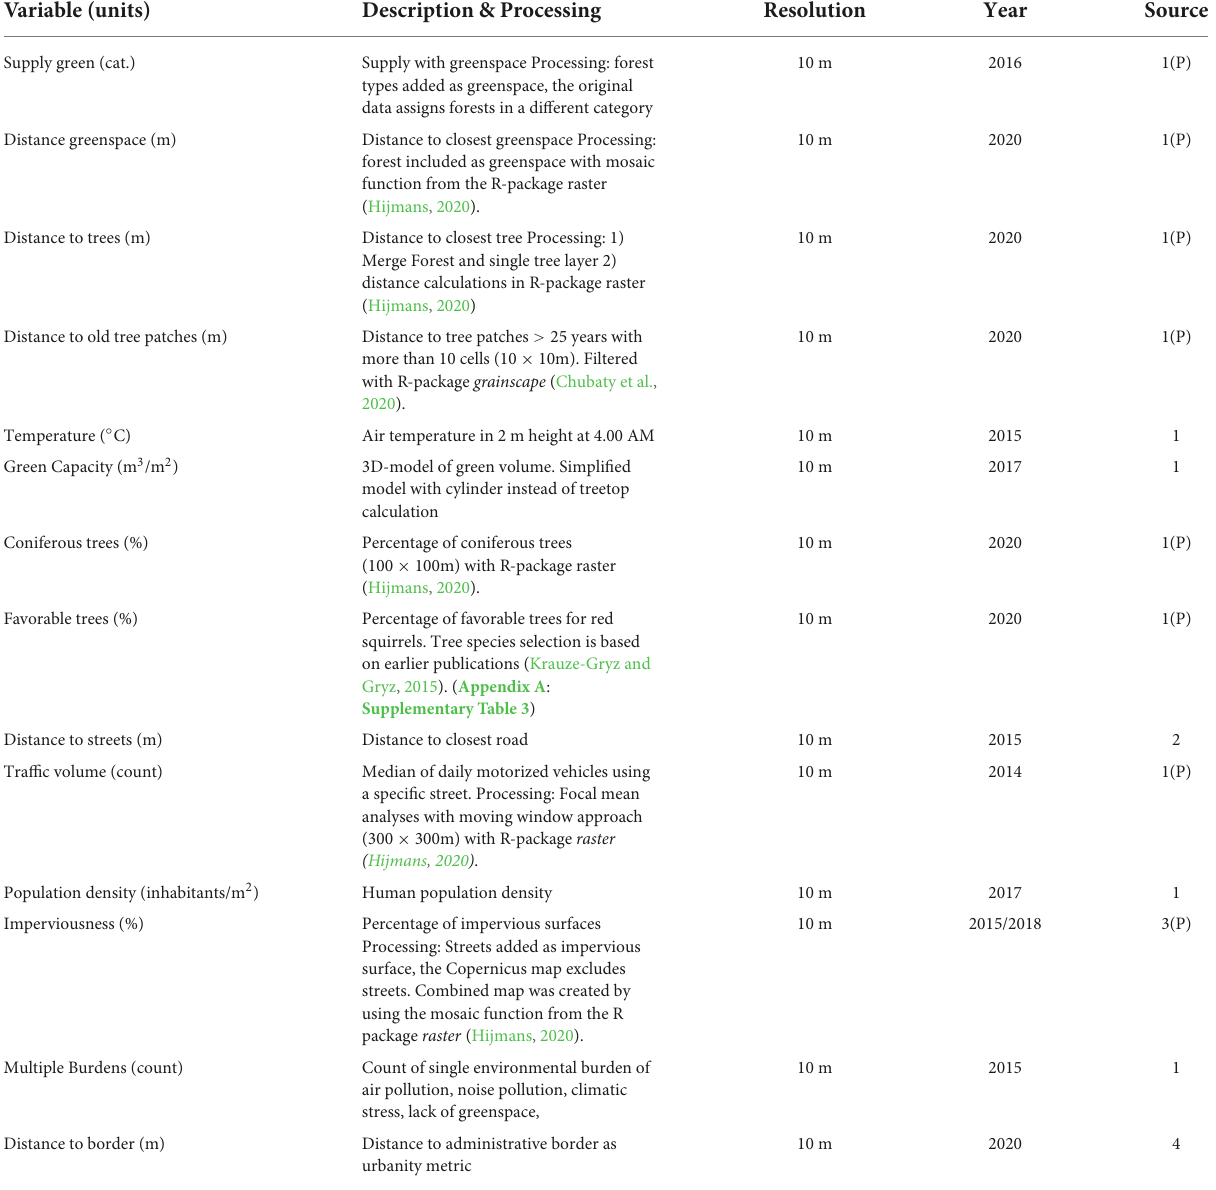
TABLE 1 Environmental variables considered for the SDMs (plots for all variables in Appendix A : Supplementary Figures 4 , 5 ) based on red squirrel’s needs and human influence factors (see main text). Variable